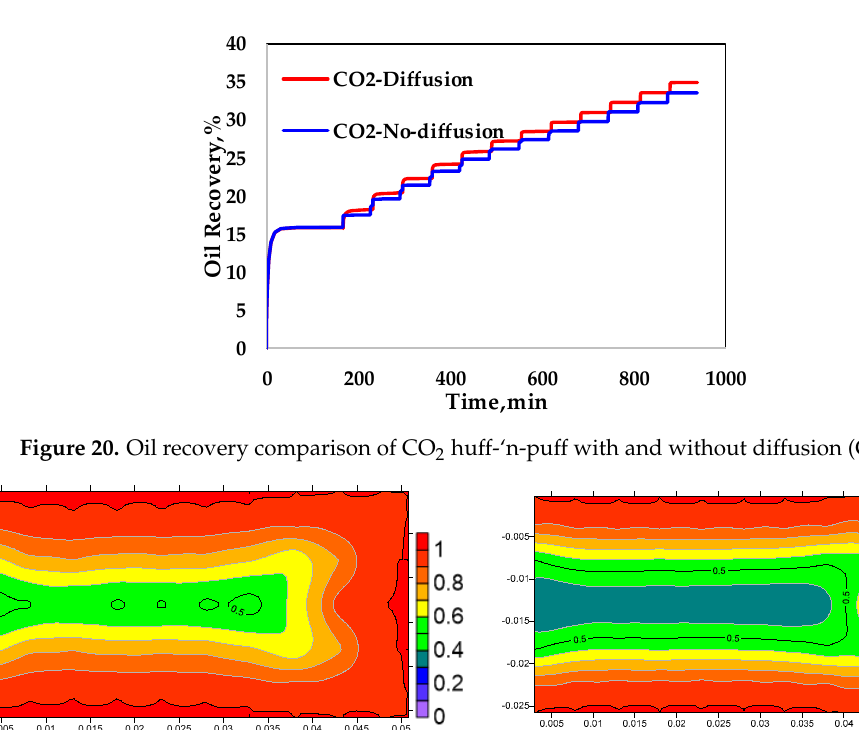
Figure 21. CO 2 global mole fraction of CO 2 huff-‘n-puff in Case-4 in soaking process (ij profile). •